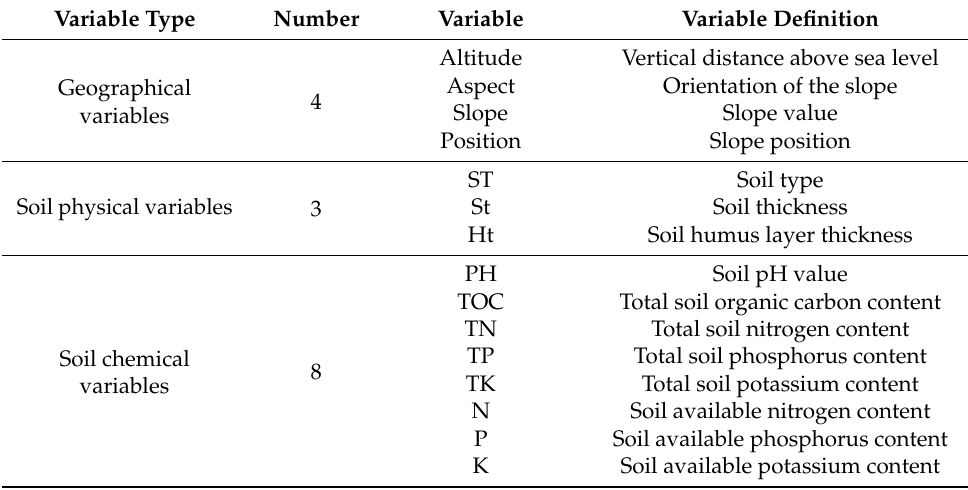
Table A1. Description of quantitative